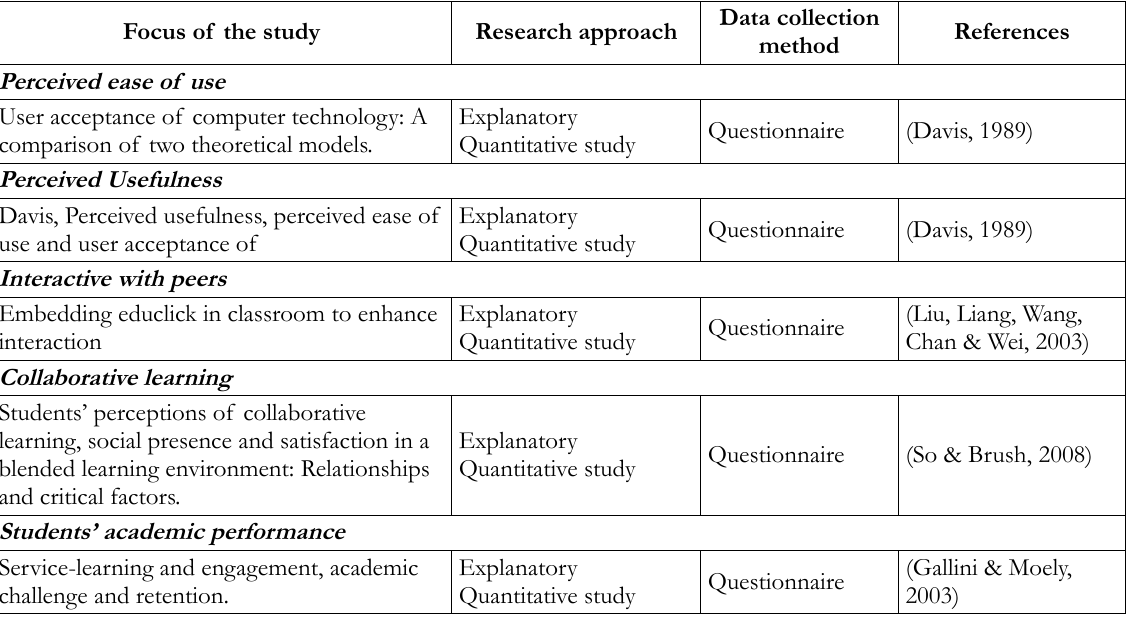
Table 1. Overview of adopted